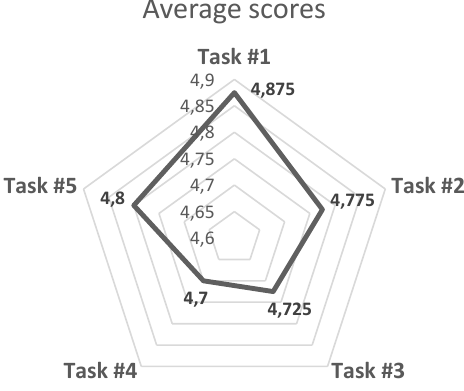
Figure 8. Radial chart showing average scores of the representative tasks. Table 3. Mean and Standard Deviation for the scores in the questions/statements of task #1